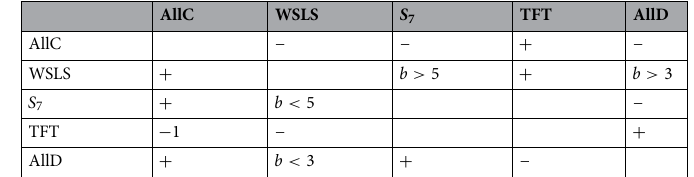
Table 3. Pairwise comparisons for the reduced strategy space. Again, we consider every pairwise combination of AllC, WSLS, S 7 , TFT, and AllD. The cells indicate the sign of π p , p + π p , q − π q , p − π q , q , the left-hand side of Eq. (25). A plus sign (minus sign) indicates that the row strategy p is favored (disfavored) over the column strategy q . If the sign depends on the benefit b , the range for which the sign is positive is shown. Blank cells indicate that the left-hand side of Eq. (25) is equal to